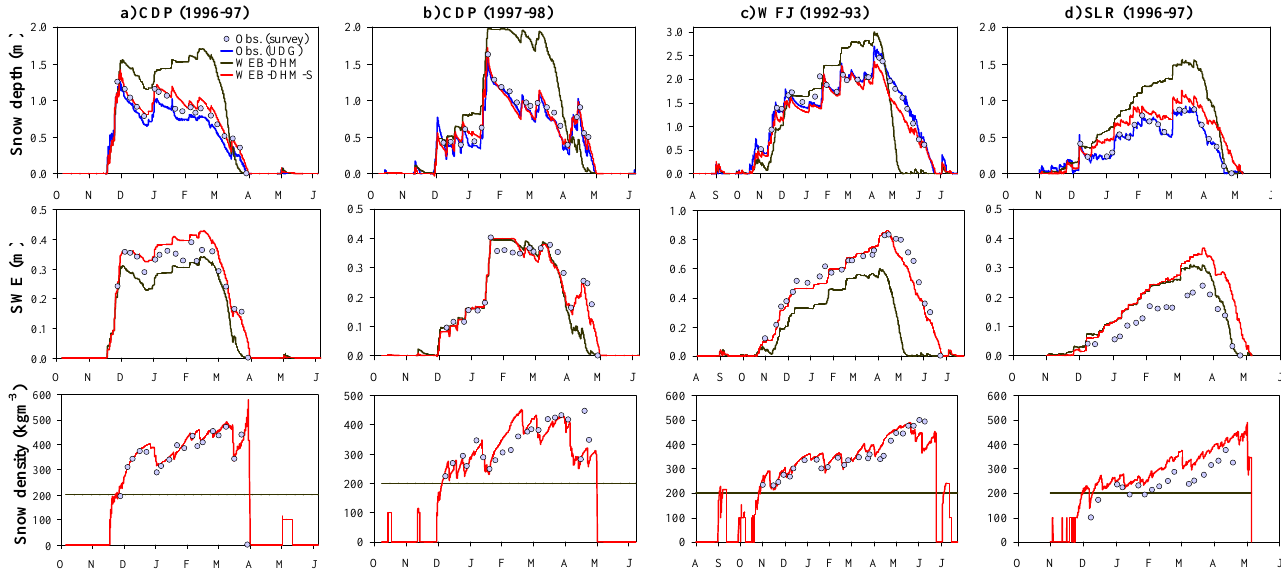
Fig. 2. Comparison of observed and simulated snow depth, SWE and density at (a) CDP (1996–1997), (b) CDP (1997–1998), (c)